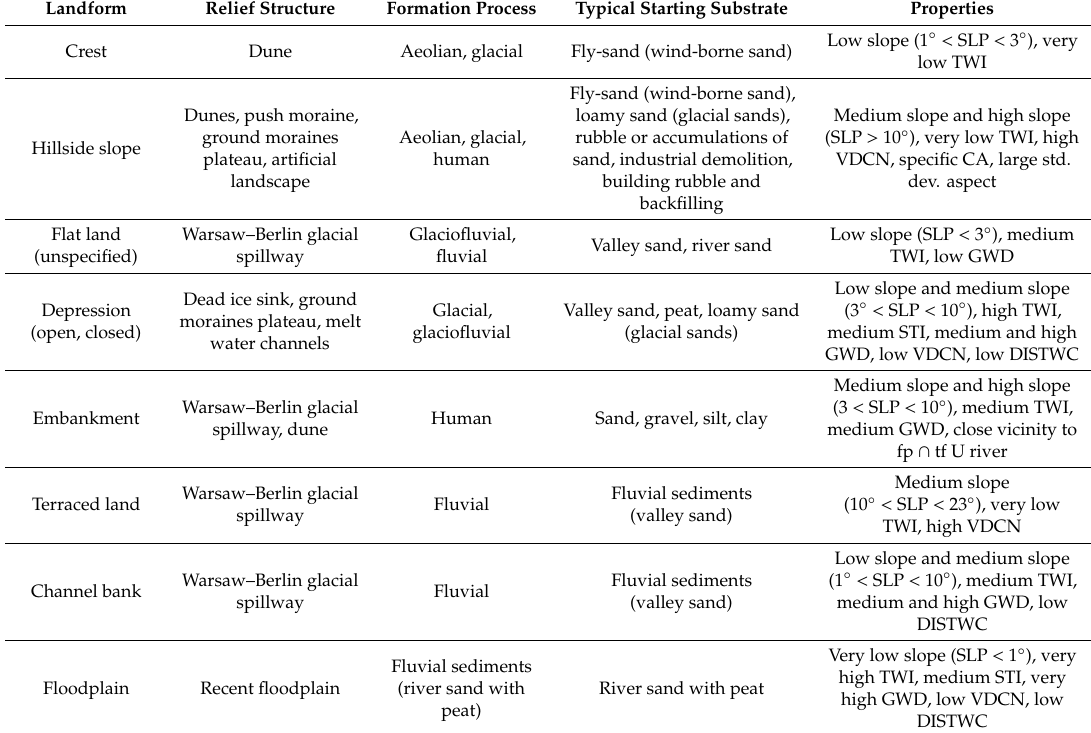
Table 3. Landforms in the study area with geomorphometric attributes.